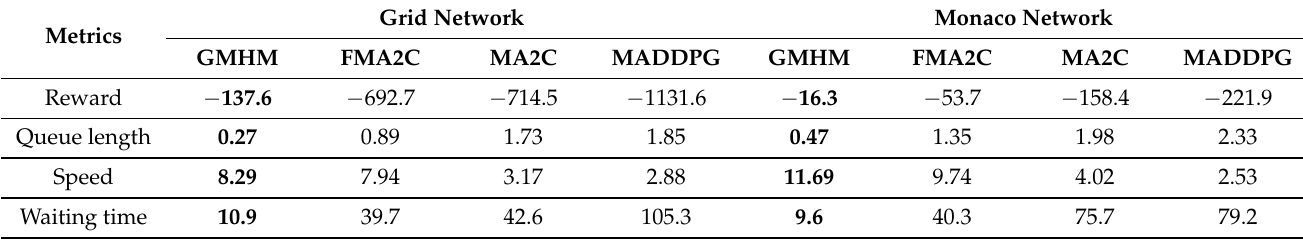
Table 1. Overall performance of different algorithms in the grid network and Monaco